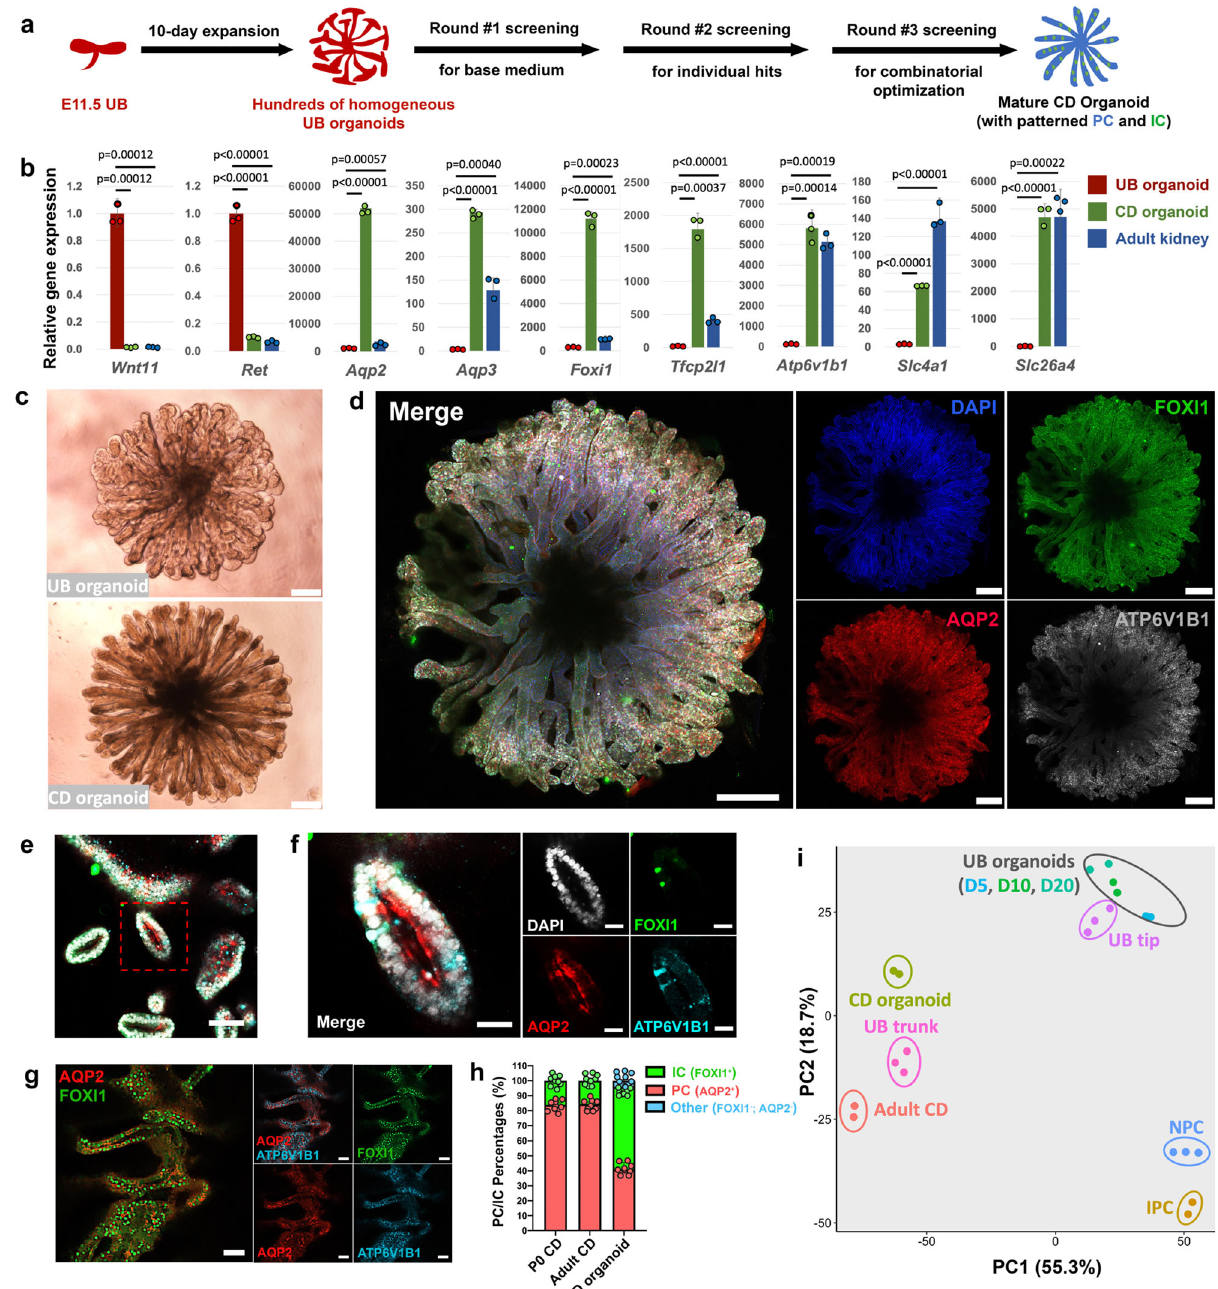
Fig. 2 Generating mature and highly organized CD organoids from UB organoids. a Schematic of the screening strategy for identifying differentiation culture condition to generate CD organoids from UB organoids. b qRT-PCR analyses of UB (red) and CD (green) organoids for UB progenitor markers Wnt11 and Ret ; PC markers Aqp2 and Aqp3 ; IC markers Foxi1 , Atp6v1b1 , Slc4a1 , and Slc26a4 ; and Tfcp2l1 that is expressed in both PC and IC. Adult mouse kidney (blue) was used as control. The signi fi cance was determined by two-tailed unpaired Student ’ s t tests. n = 3. c Bright fi eld images showing the morphologic differences between UB and CD organoids. d – g Whole-mount immunostaining analyses of CD organoids for PC marker AQP2, and IC markers FOXI1 and ATP6V1B1, showing the distribution of these two cell types within the organoid. f Shows the higher-power images for the boxed region in ( e ). h Comparison of PC and IC ratios in postnatal Day 0 (P0) mouse CD, adult mouse CD, and CD organoids. Whole-mount immunostaining images (CD organoids), or section staining images (P0 and adult kidneys) stained for AQP2 (PC) and FOXI1 (IC) were quanti fi ed for ratios of PC and IC in the CD organoid or the kidney ’ s collecting duct. Each column represents counts from nine different fi elds of view ( n = 9, three fi elds were randomly selected from each of the three biologically independent samples). i Principal component analysis (PCA) of RNA-seq data. Different colors and oval circles represent different primary kidney cell populations (NPC, IPC, UB tip, UB trunk, and adult CD cells), or UB organoids cultured for 5 (D5), 10 (D10), and 20 days (D20), or CD organoids. Scale bars: c , d 200 µ m, e 100 µ m, f 25 µ m, g 40 µ m. All data are presented as mean ± s.d. Source data are provided as a Source Data fi